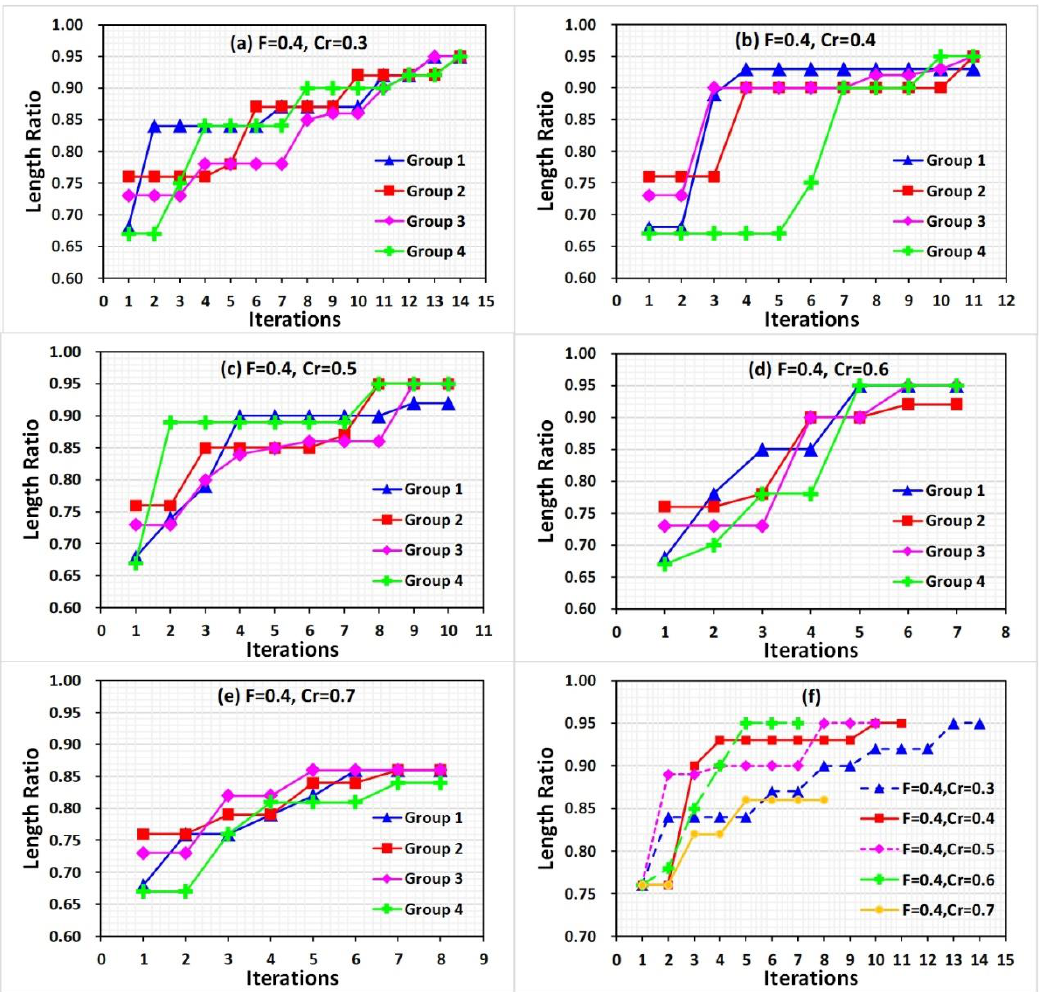
Figure 5. Differential evolution based on the length ratio in feedback control for pushing CNT operation with ( a ) Cr = 0.3, ( b ) Cr = 0.4, ( c ) Cr = 0.5, ( d ) Cr = 0.6, and ( e ) Cr = 0.7. The peak length ratio value in each step iteration of every set experiments is listed in ( f ). In each iteration, four groups of combinations were studied.